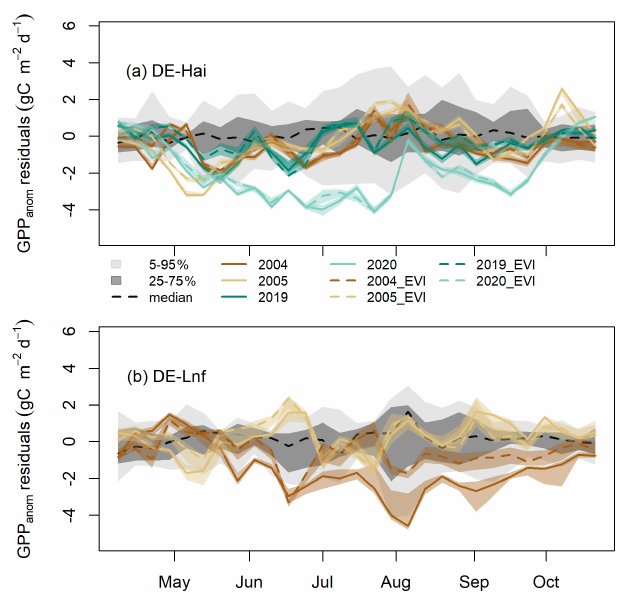
Figure 5. Residuals of GPP anomalies from RF and RF EVI (see Sect. 3.6) in legacy years at (a) DE-Hai and (b) DE-Lnf. Resid- uals of GPP anomalies are characterised by observed minus pre- dicted GPP anomalies (GPP anom residuals). The coloured lines and bands show the median and 5th–95th percentile GPP anom residuals of ensemble model runs (see Sect. 3.4), respectively. The solid and dashed lines show the residuals based on RF and RF EVI , respec- tively. The model uncertainties from RF EVI (dark and light grey shaded areas, respectively) are characterised by the 25th–75th and 5th–95th quantile ranges of GPP anom residuals in non-legacy years. The black dashed line was the median of GPP anom residuals from RF EVI in non-legacy years. The ticks denote the start of each month. Figure S4 shows the results for April–June and August–October at DE-Hai in more detail.